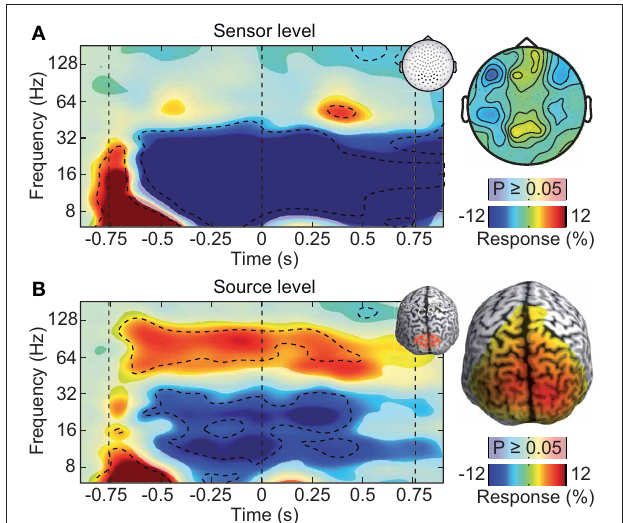
FIGURE 2 | Neuronal response to the visual-motion stimulus at the sensor and source levels. (A) Left: power response relative to prestimulus baseline resolved in time and frequency for occipito-parietal electrodes of interest (see inset for electrode positions). Statistically significant differences are indicated by saturated colors ( t -test, p < 0 . 05), and by contour lines ( t -test, p < 0 . 05, Bonferroni corrected for time and frequency). Right: scalp topography of power responses in the time-frequency range indicated by the dashed box in the left panel. (B) Left: power response relative to prestimulus baseline resolved in time and frequency for an occipito-parietal source region of interest (see inset for region of interest; CS: central sulcus). Right: spatial power distribution in the time-frequency range − 0.65 to 0.05s and